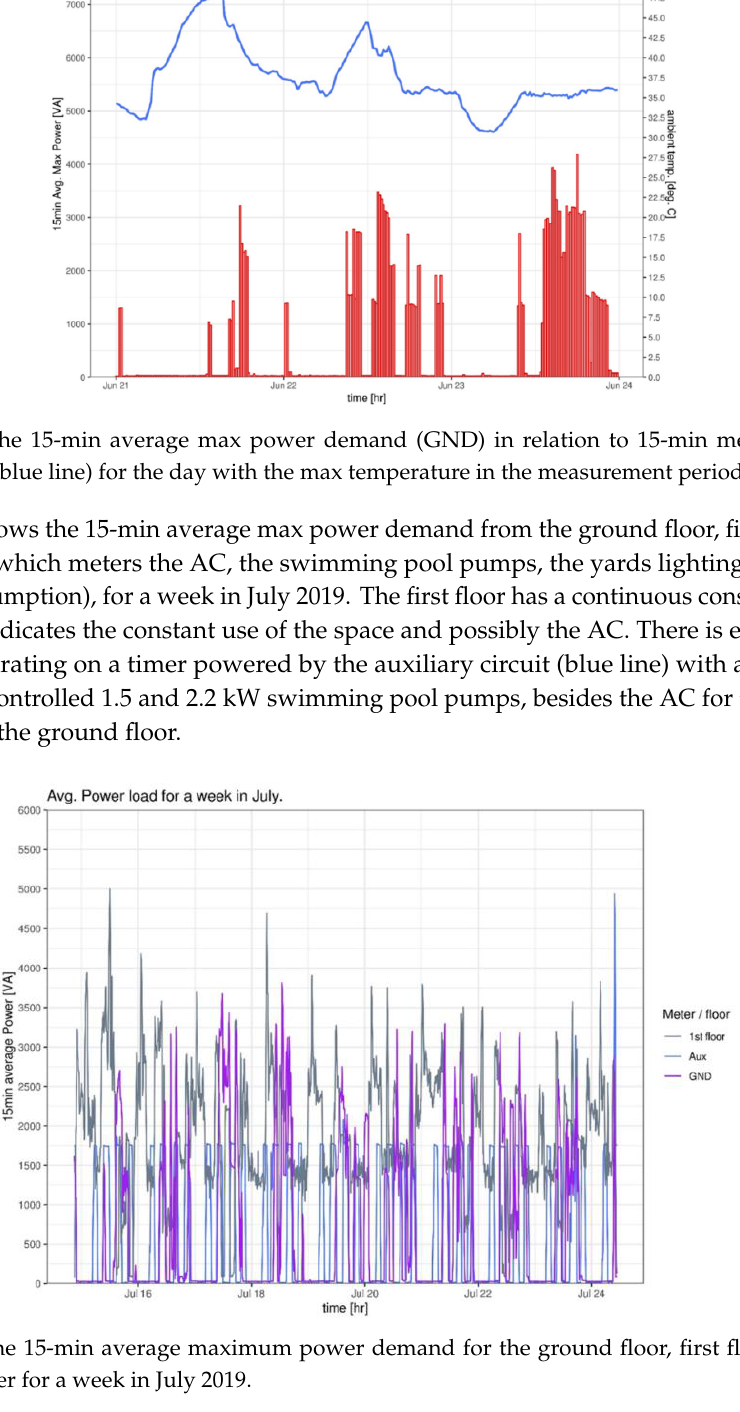
Figure 17. Monthly AC electricity demand in relation to the number of cooling degree days. The intercept (CDD = 0) shows the base, non-cooling electricity demand. 4.2. Shading Simulation A shading si mulation was run for a year to identify the potential for the use of the villa’s rooftops for PV electricity generation. A GIS-based solar simulation model is used to estimate the long-term impact of shading on solar systems. Therefore, two constant coefficients have been chosen to